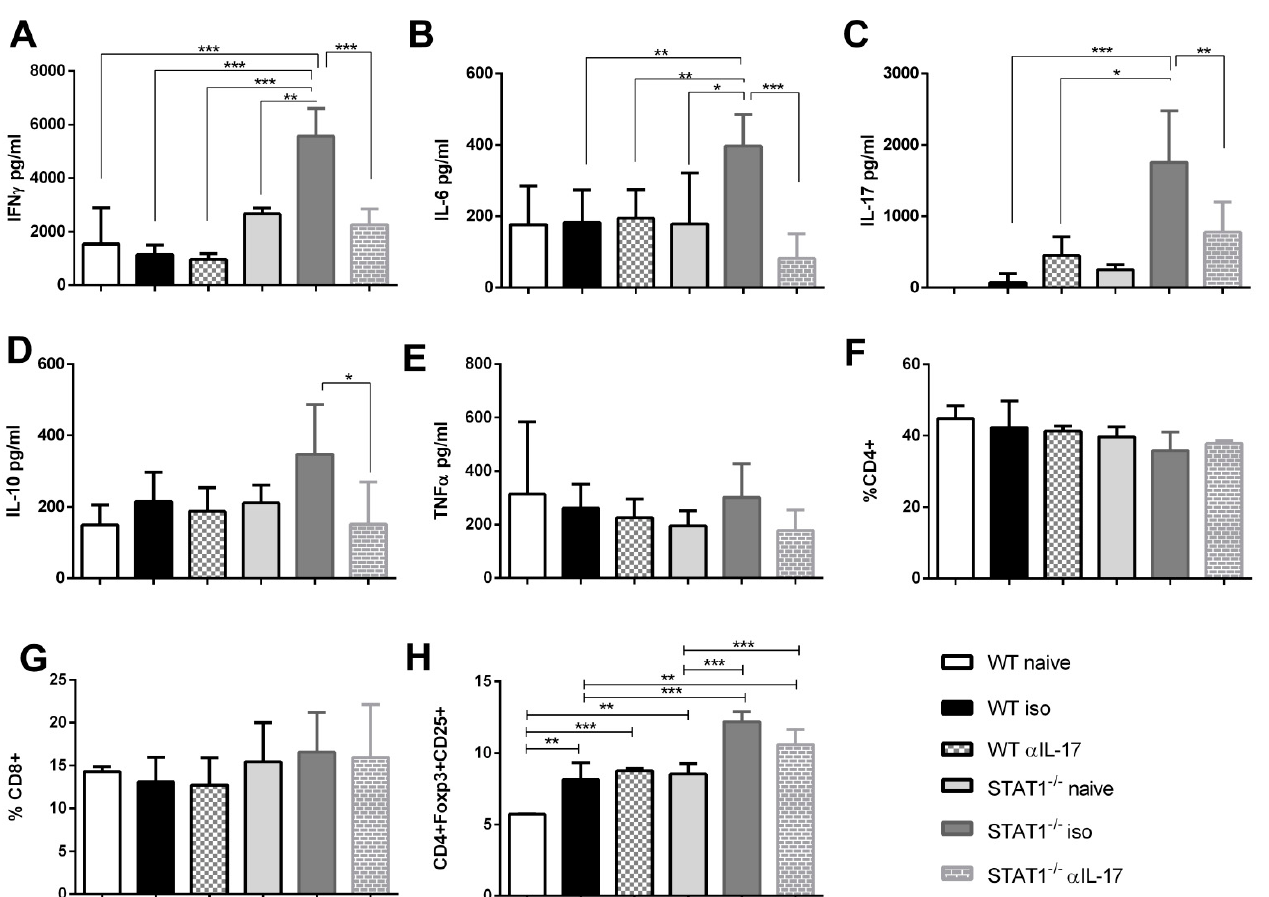
Figure 5. Treatment with anti-IL-17 antibody reduced the pro-inflammatory cytokine production in the spleens of STAT1 -/- mice. Mice were treated as in Figure 3A. In total, 1 × 10 5 spleen cells were obtained at day 20 after AOM/DSS treatment and were stimulated with α -CD3 for 72 h to analyze the expressions of ( A ) IFN- γ , ( B ) IL-6, ( C ) IL-17A, ( D ) IL-10, and ( E ) TNF- α cytokines using the Mouse Th1/Th2/Th17 CBA Kit (BD ® ). Total spleen cells were analyzed by flow cytometry. Frequencies of total ( F ) CD4+ cells, ( G ) CD8+ cells, and ( H ) CD4+Foxp3+CD25+ T cells of tumor-bearing WT iso, STAT1 -/- iso or WT or STAT1 -/- mice treated with anti-IL-17 neutralizing antibody. Data shown are the mean ± SEM of three or four individual mice per group and are representative of two individual experiments with similar results. * p < 0.05, ** p < 0.01, *** p < 0.001.